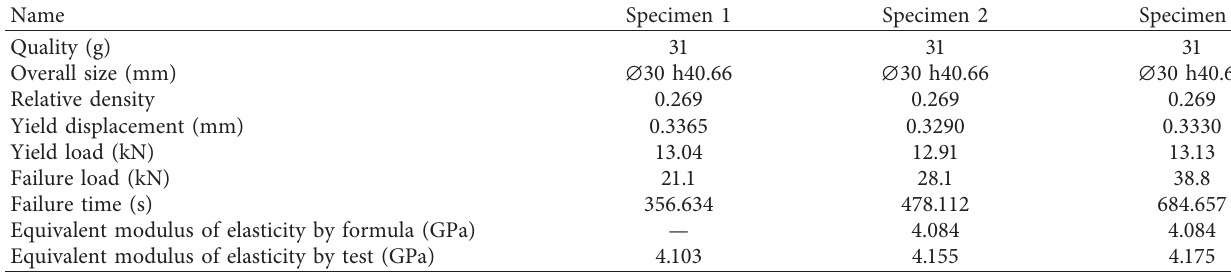
Table 3: Analysis of test results of three kinds of